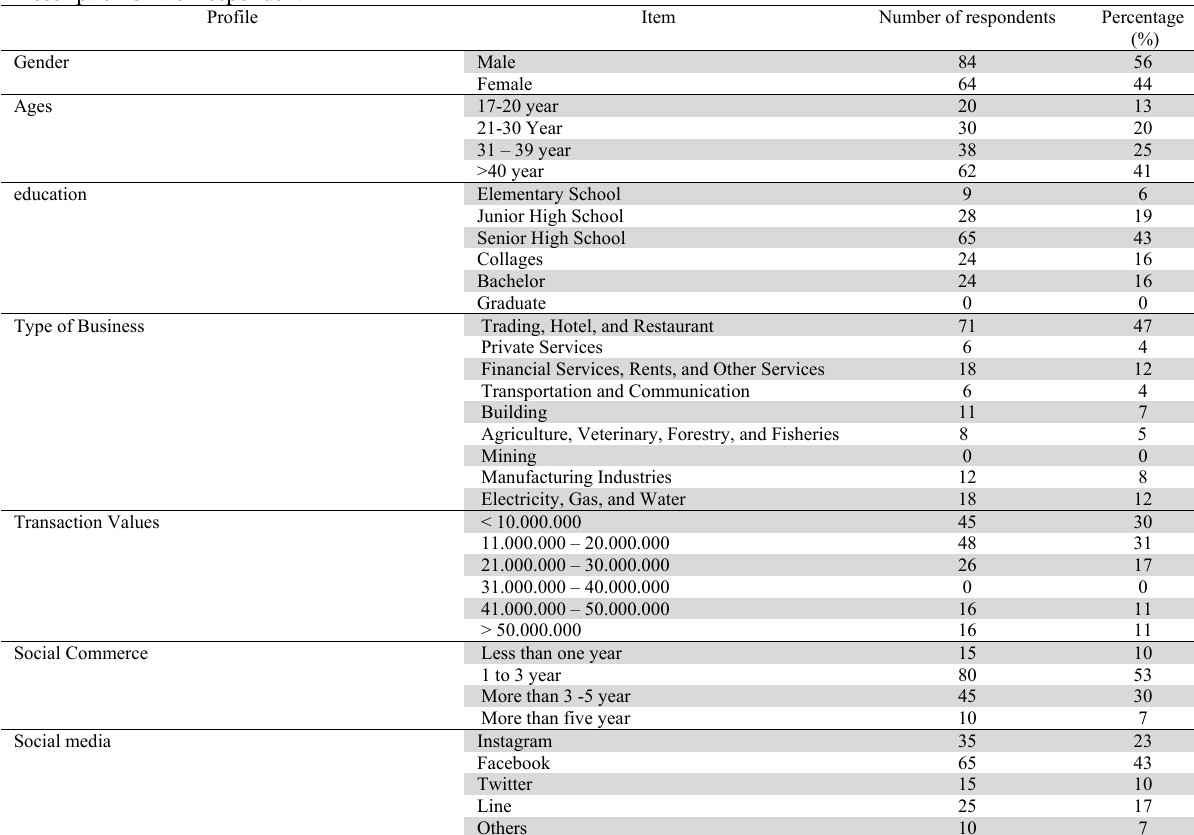
Description of the Respondent Profile Item Gender